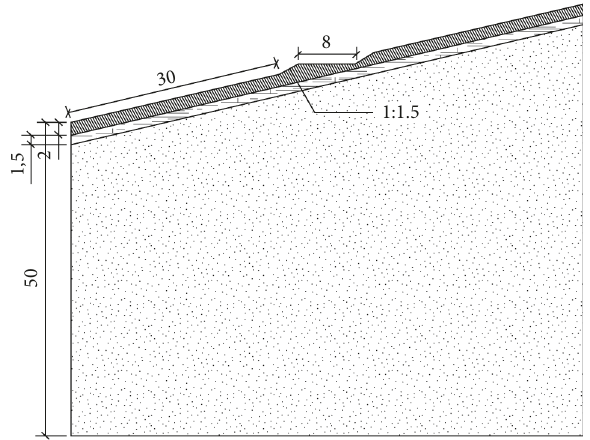
Figure 4: Two-dimensional calculation model of roadbed (unit: m).